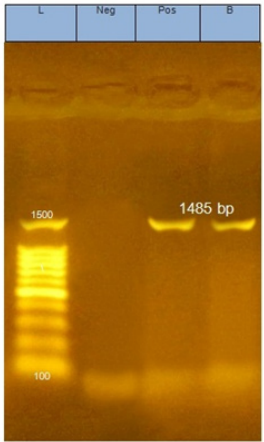
Fig. 1. Agarose gel electrophoresis of PCR products including the amplified 16S rRNA gene of two LAB isolates. Lane 1, DNA marker; Lane 2, negative control; Lane 3, E.faecium CK21; Lane 4 L.fermentum